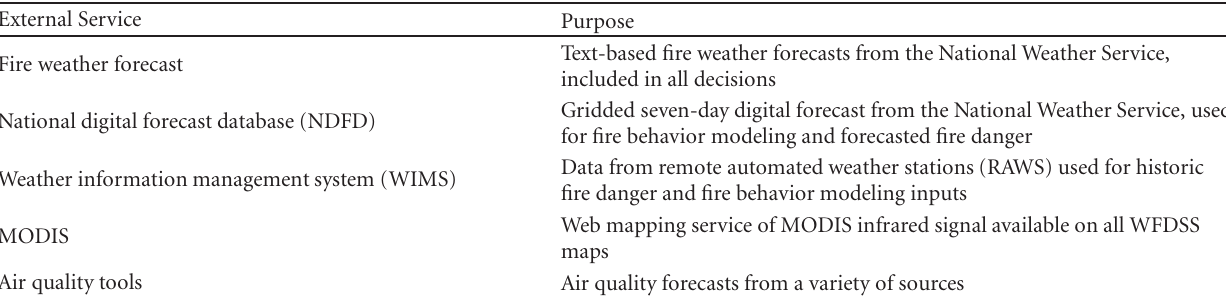
Table 5: List of WFDSS external